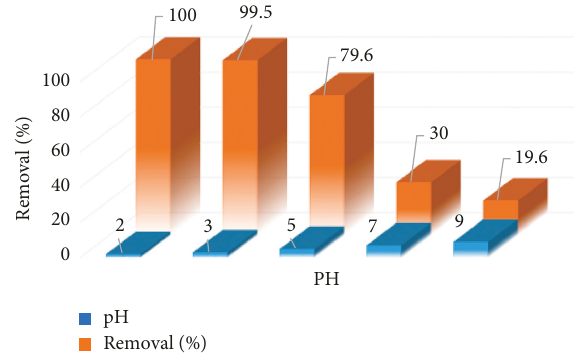
Figure 7: Influence of pH on the adsorption of 10 mg · L − 1 (EBT) dye by 0.1g/50 mL NSG nanocomposite for a contact time of 20min.